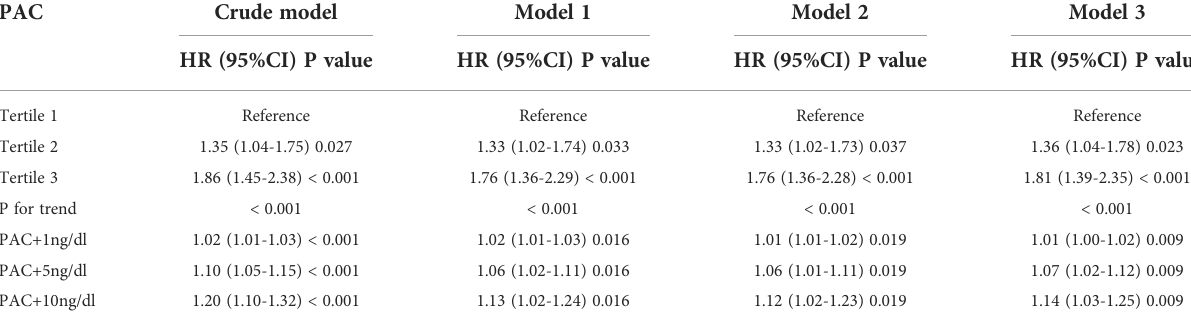
Model 1: adjusted for age, T2DM at baseline, Duration of hypertension ≥ 5 years, cigarette consumption, alcohol intake, waist circumference, SBP, DBP, eGFR, TG, HDL-C, Lp(a), serum potassium, PRA; Model 2: adjusted for gender, age, BMI, T2DM at baseline, Duration of hypertension ≥ 5 years, cigarette consumption, alcohol intake, AHI ≥ 15, waist circumference, SBP, DBP, eGFR, TC, TG, HDL-C, LDL-C, Lp(a), serum potassium, PRA; Model 3: Model2+ antihypertensive agents, statins, antiplatelet agents, regular CPAP treatment.